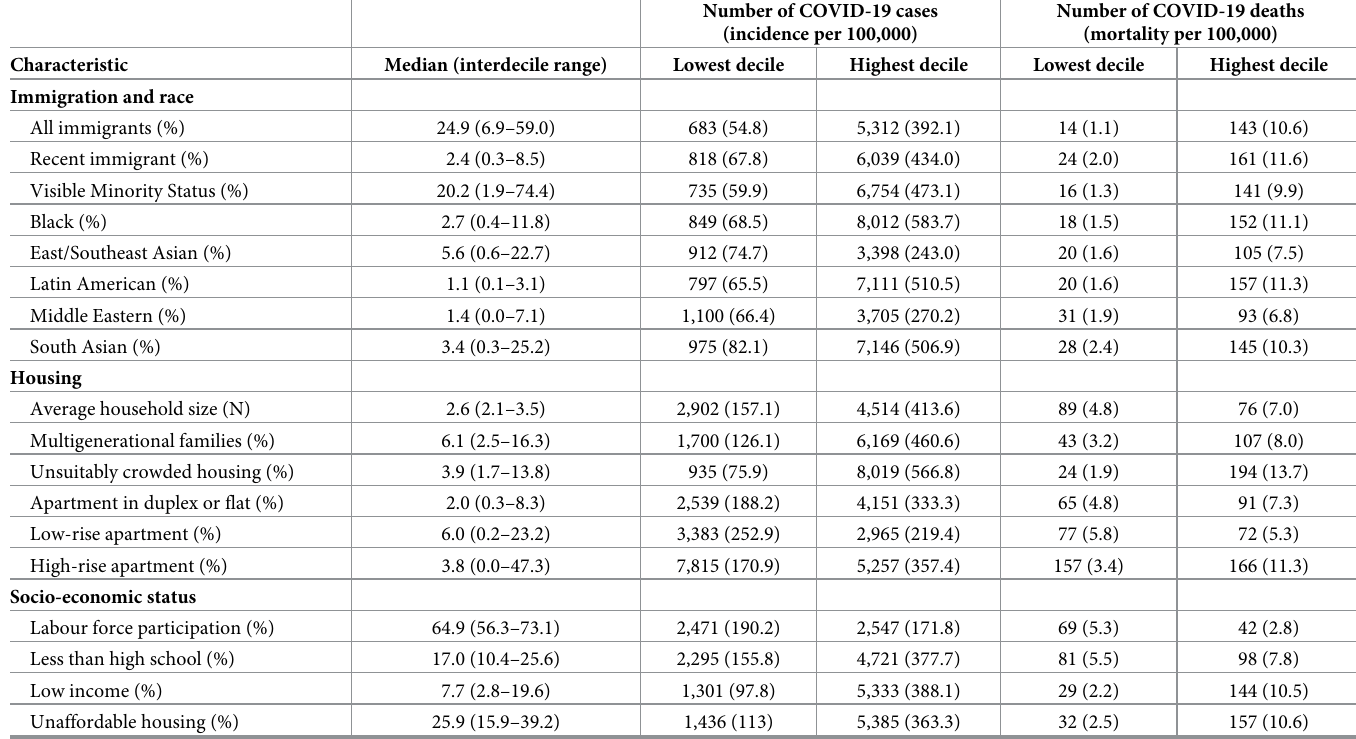
Table 1. Median neighbourhood socio-demographic characteristics, interdecile range, and incidence and mortality of COVID-19 in the lowest and highest deciles of a given neighbourhood characteristic.